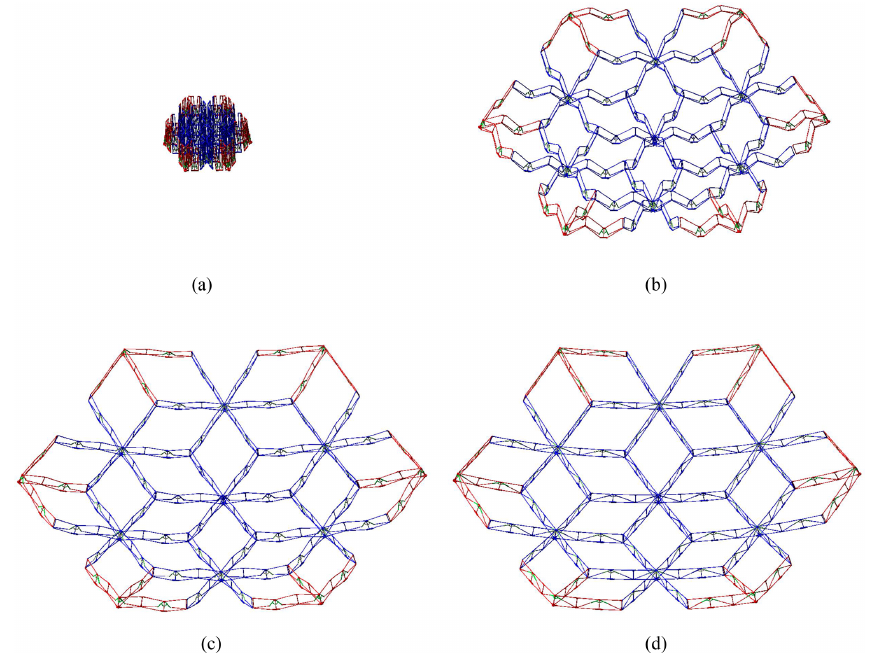
Figure 14. Deployment simulation of deployable antenna mechanism, where (a) t = 0s, (b) t = 15s, (c) t = 40s, and (d) t = 100s.